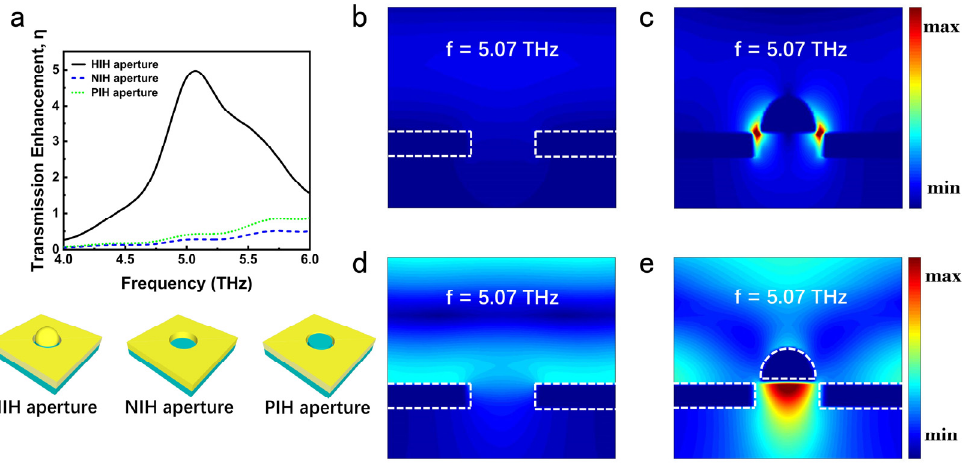
Figure 4. ( a ) The transmission enhancement spectra and schematic representations for three cases of aperture without grooves; the electric field distributions for ( b ) NIN aperture and ( c ) HIH aperture; the magnetic field distributions for ( d ) NIN aperture and ( e ) HIH aperture.